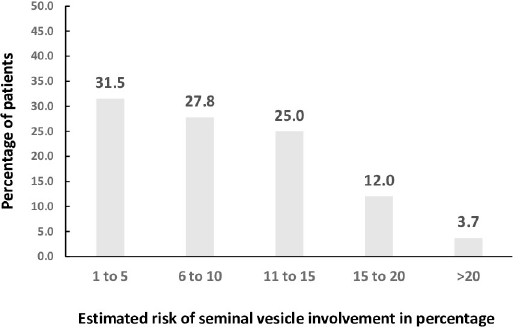
Fig 4. Estimated risk of seminal vesicle involvement using Partin tables in 108 men with confirmed seminal vesicle disease at the time of prostatectomy.